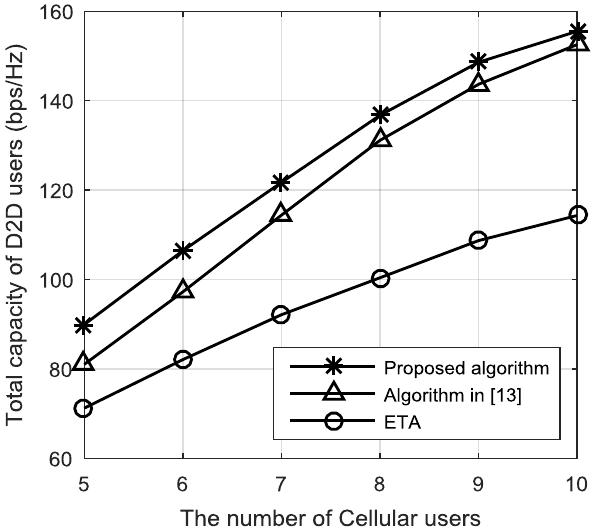
Figure 5. Total capacity of D2D users with different number of cellular users.